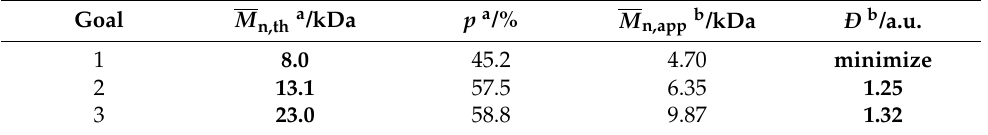
Table 2. Predicted responses of arbitrarily chosen polymerizations for empiric validation of the prediction models. The polymerization targets are highlighted in bold letters.